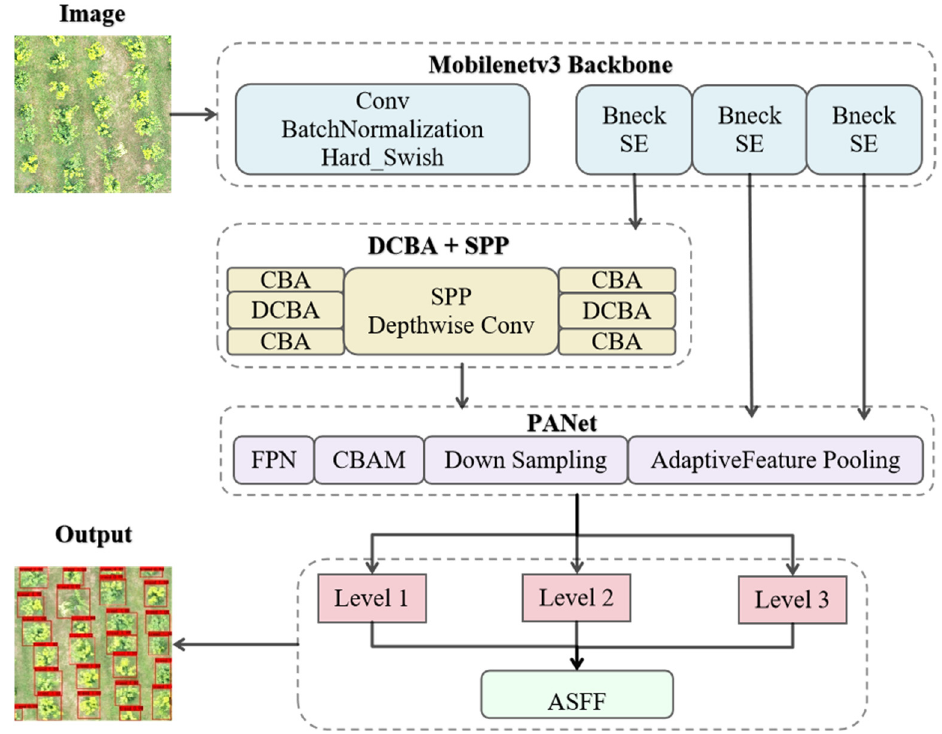
Figure 2. Overview of the YOLOv4 Model.